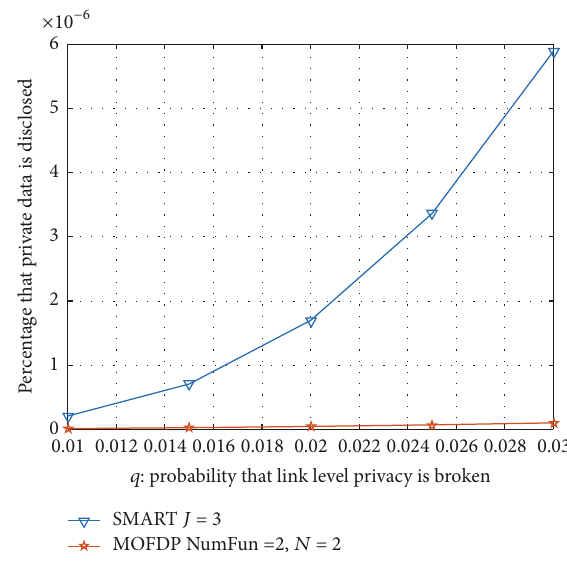
Figure 3: Comparison results when 𝐽 = 3 , NumFun = 2, 𝑁 = 2